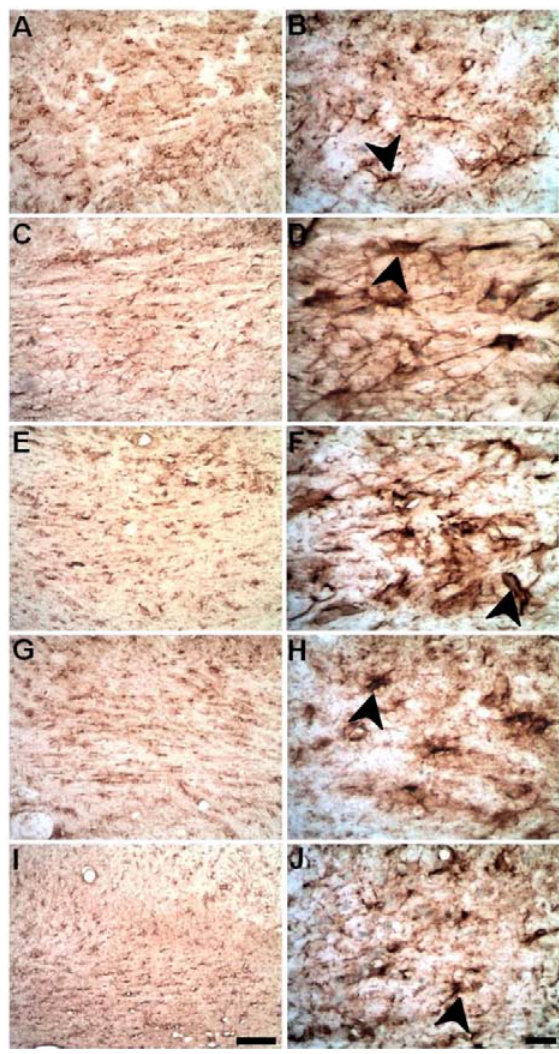
Figure 6. Progressive astrocyte activation as revealed anti-GFAP immunolabeling in the CC. Control animal injected with sterile saline ( A , B ) or ischemic animals injected with ET-1 at 3 ( C , D ); 7 ( E , F ); 14 ( G , H ); and 30 ( I , J ) PLDs. Scale bars: 20 μ m ( A , C , E , G , J ) and 100 μ m ( B , D , F , H , I ). Left-sided photomicrographs in lower magnification with a scale bar of 20 μ m, and right-sided ones, with higher magnification with a scale bar of 100 μ m.